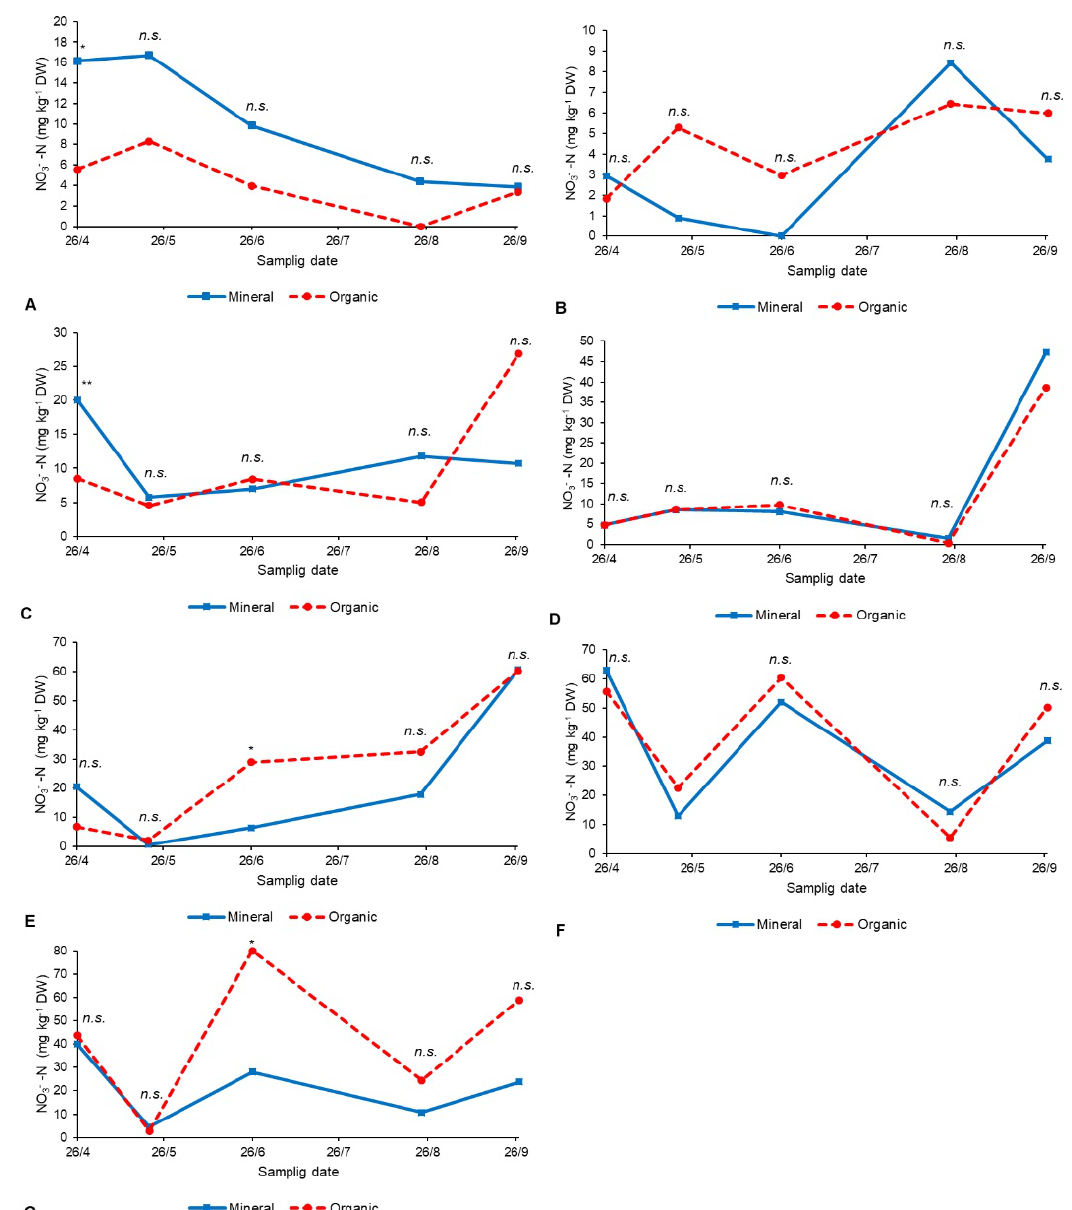
Figure 1. Effect of fertilization treatment on soil nitrate (NO 3 − -N) during the season in apricot ( A ), peach ( B ), plum ( C ), apple ( D ), pear ( E ), yellow kiwifruit ( F ) and green kiwifruit ( G ) orchard.